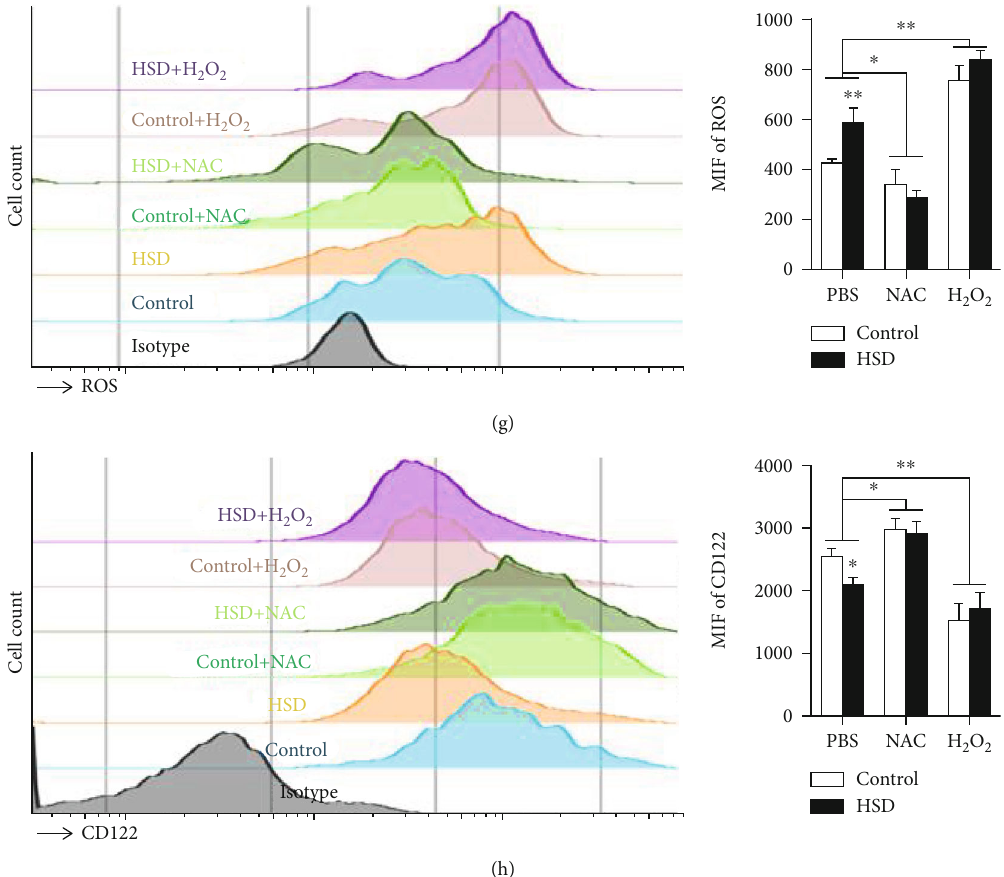
Figure 7: HSD increases gp91phox-mediated ROS production following downregulation of CD122 in NK cells. Representative fl ow cytometry pro fi les and mean fl uorescence intensity of T-bet (a), Eomes (b), E4BP4 (c), ROS (d), and CD122 (e). Expression levels of the NADPH oxidase subunits, gp91phox and p47phox, were detected by western blotting (f). Representative fl ow cytometry pro fi les and mean fl uorescence intensity of ROS in NK cells following inhibition by N-acetylcysteine or induction by H cytometry pro fi les and mean fl uorescence intensity of CD122 in NK cells following inhibition or induction of ROS (h). All the data represent at least three independent experiments. Data are shown as the means ± SEM . Unpaired Student ’ s t -tests (two-tailed) were performed using the Prism software. A P value of < 0.05 was considered signi fi cant. ∗ P < 0 : 05 , ∗∗ P < 0 : 01